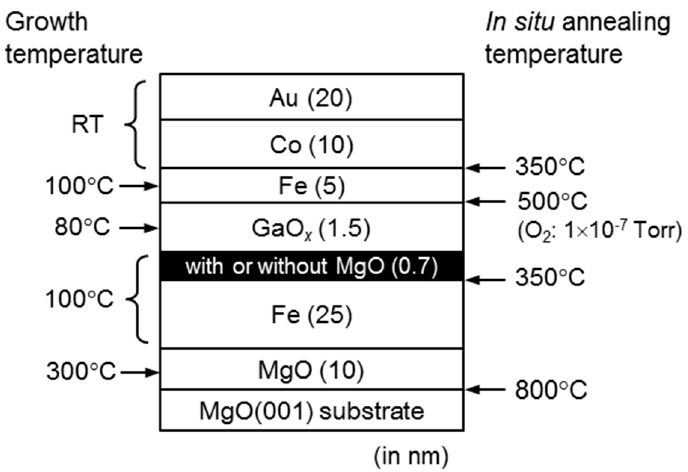
Figure 1. The structure of the magnetic tunnel junction (MTJ) stack designed for this study. Figures at both sides show growth temperatures and in situ annealing conditions.